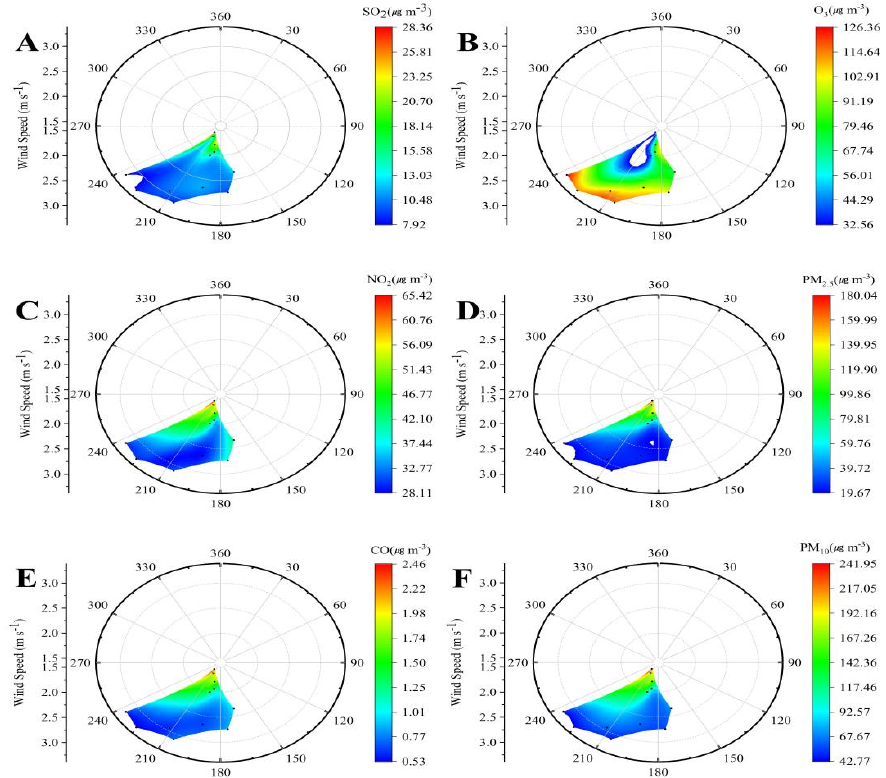
Figure 4. Polar plots of SO 2 , NO 2 , CO, O 3 , PM 2.5, and PM 10 concentrations in the Changji. ( A ) SO 2 . ( B ) ( B ) O 3 . ( C ) NO 2 . ( D ) PM 2.5 . ( E ) CO. ( F ) PM O 3 . ( C ) NO 2 . ( D ) PM 2.5 . ( E ) CO. ( F ) PM 10.